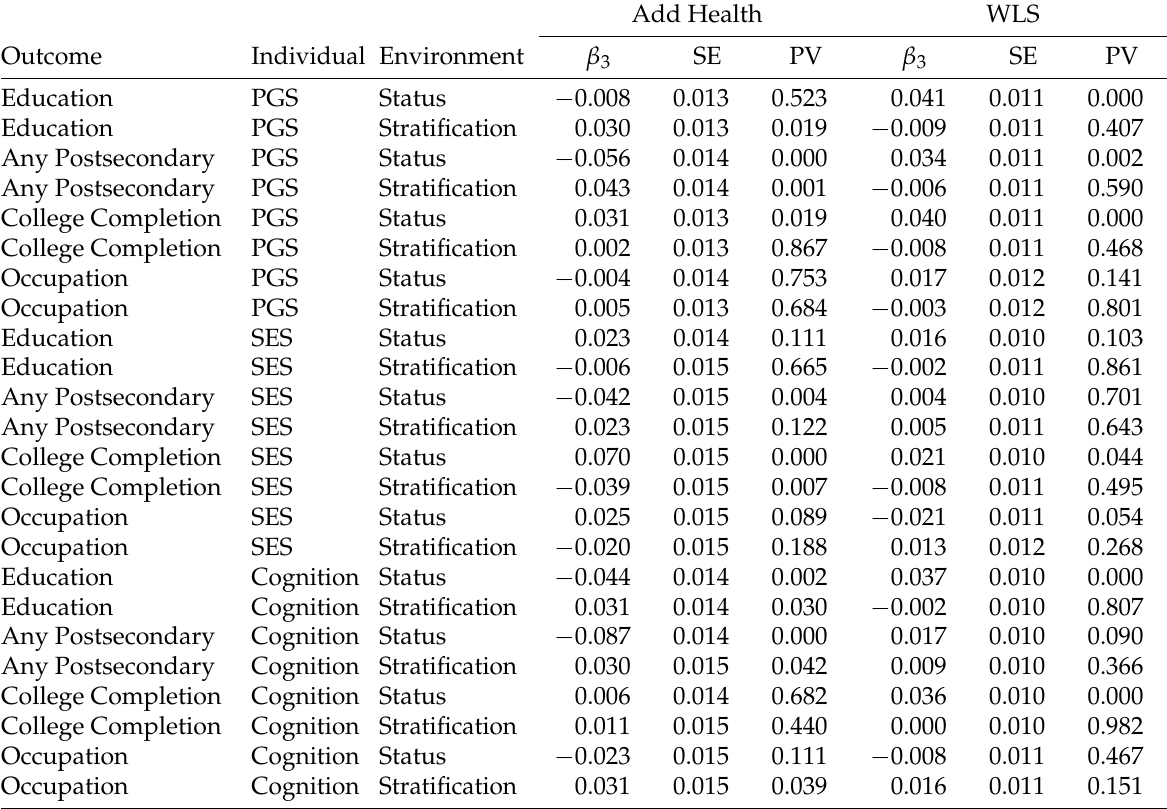
Table 2: Estimated GxE coefficients from equation 2 (direct approach) based on candidate environments (outcome and key predictors are standardized in all